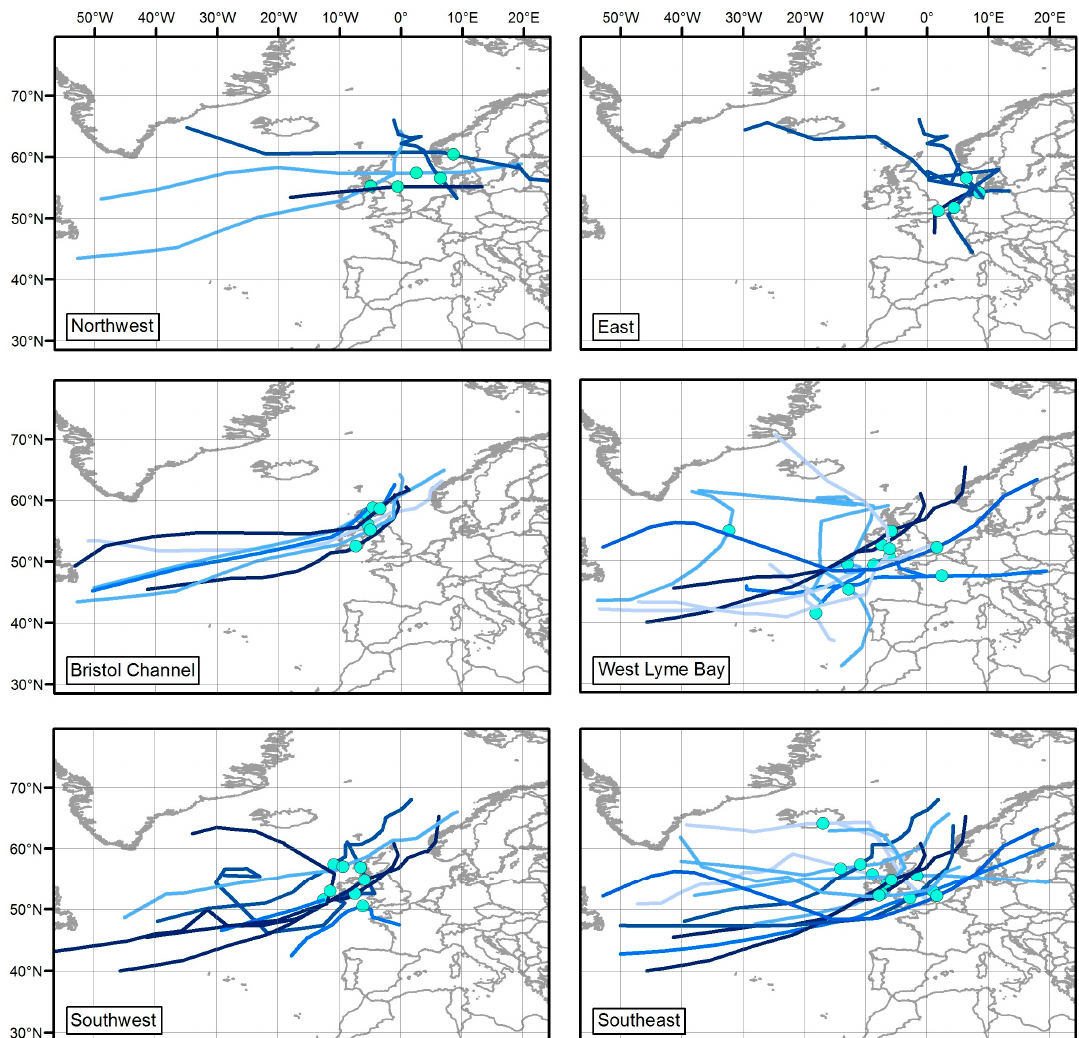
Figure 5. Storm tracks for the extreme wave events shown in Figures 3 and 4. The tracks are grouped according to the six discrete regions that were identified. The green circles indicate the location of the center of the low pressure system when the maximum significant wave height was recorded. Darker colored tracks represent longer return periods.